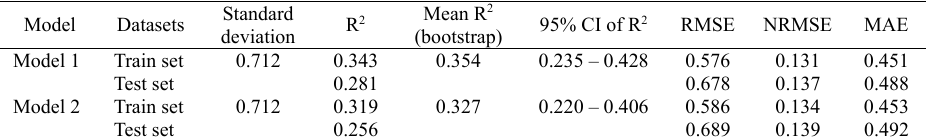
Table 3: Results of model validation Fig. 6: Tests for the linear assumption of Models 1 and